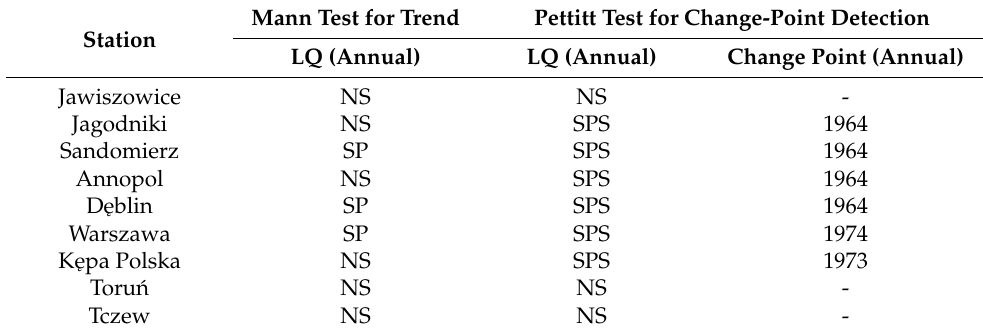
Table 7. The results of testing ( α = 0.05) for trend and change point in annual minimum flow (LQ) series in the 1951–2018